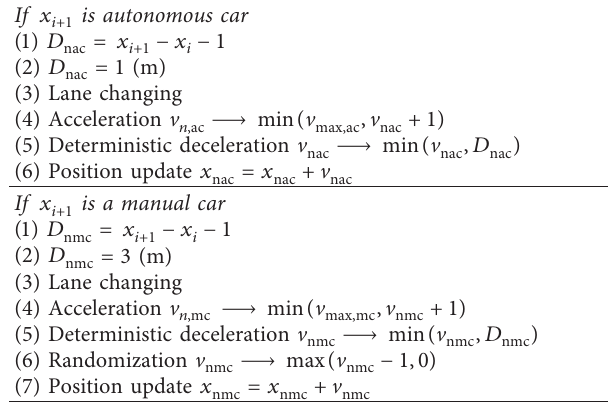
Table 2: Rules for updating the position of different cars in the model.